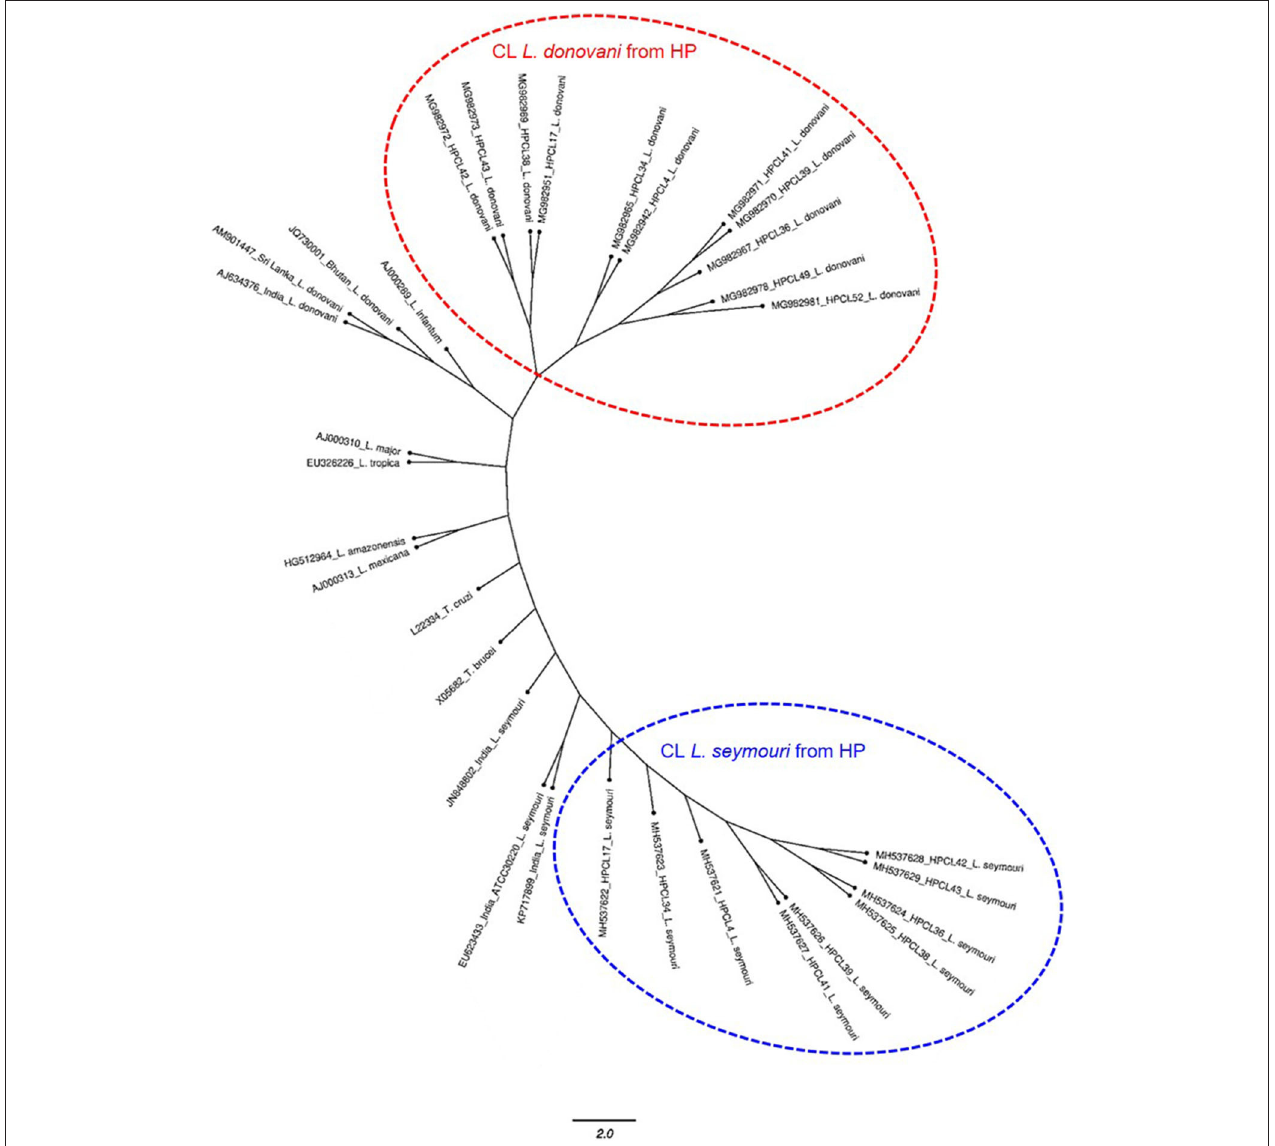
FIGURE 2 | Phylogenetic tree of ITS1 gene sequences from CL test samples with single and dual-band amplification patterns ( ∼ 320 bp and ∼ 400 bp band size test samples, designated as HPCL_Ld series corresponding to ∼ 320 bp band and HPCL_Ls series corresponding to ∼ 400 bp band, numbered in order of their collection) and ITS1 sequences of standard Leishmania , Leptomonas and Trypanosoma isolates from Genbank was obtained using Maximum Likelihood method with 1,000 bootstraps using dnaml program of PHYLIP package.